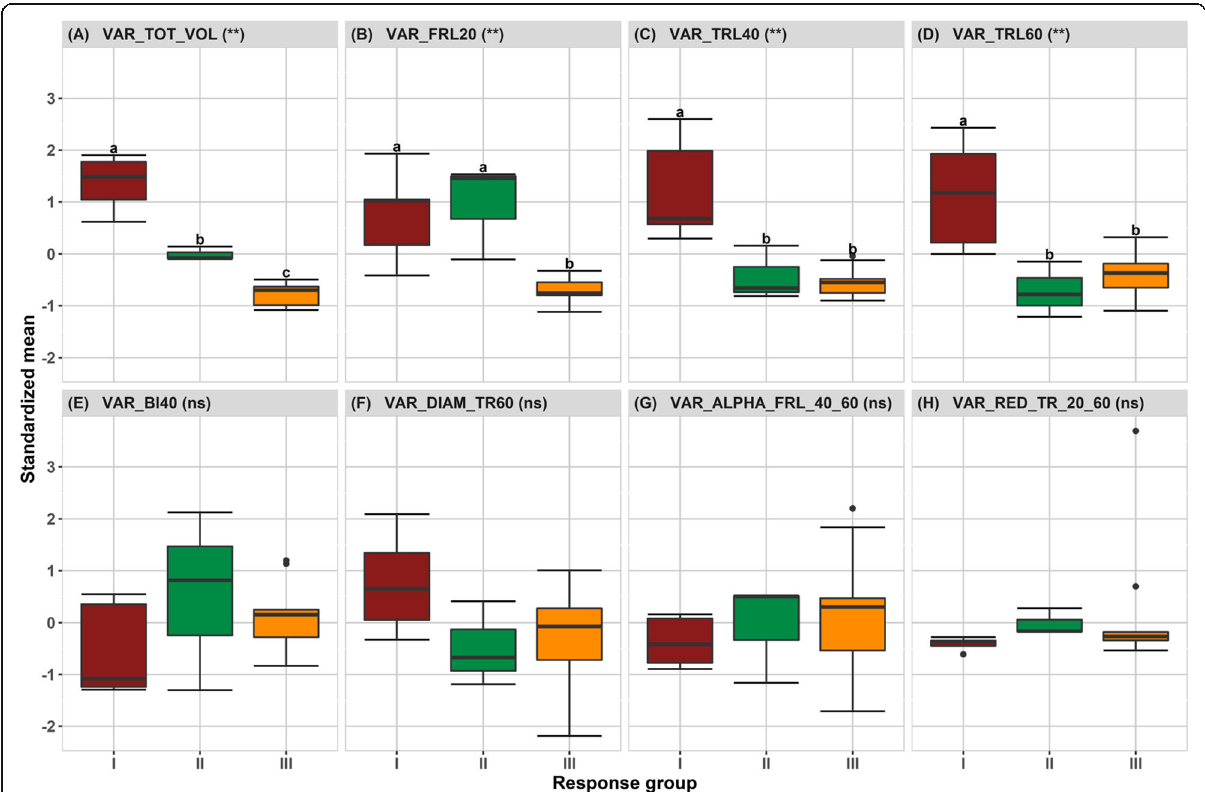
Fig. 3 Box-plots of the standardized relative variations of the eight selected root traits among the 17 accessions gathered in 3 response groups (RG). The symbol in brackets indicates the response group effect (** significant at 1% and ns not significant). The averages followed by the same letter do not differ statistically according to the Tukey test (p-value 0.05). I, II, III refer to response groups RG I, RG II and RG